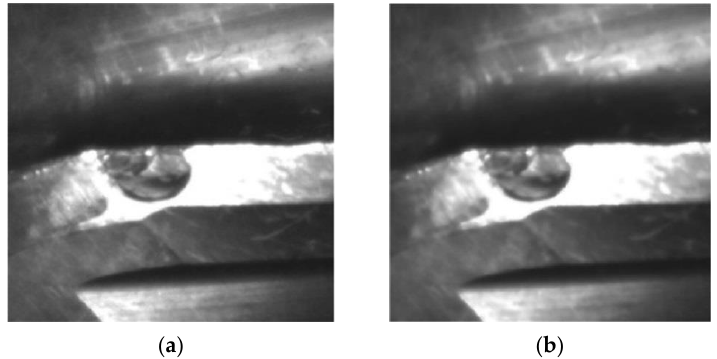
Figure 4. Comparison of flank face image before and after denoising: ( a ) Undenoised image; ( b ) Denoised image.